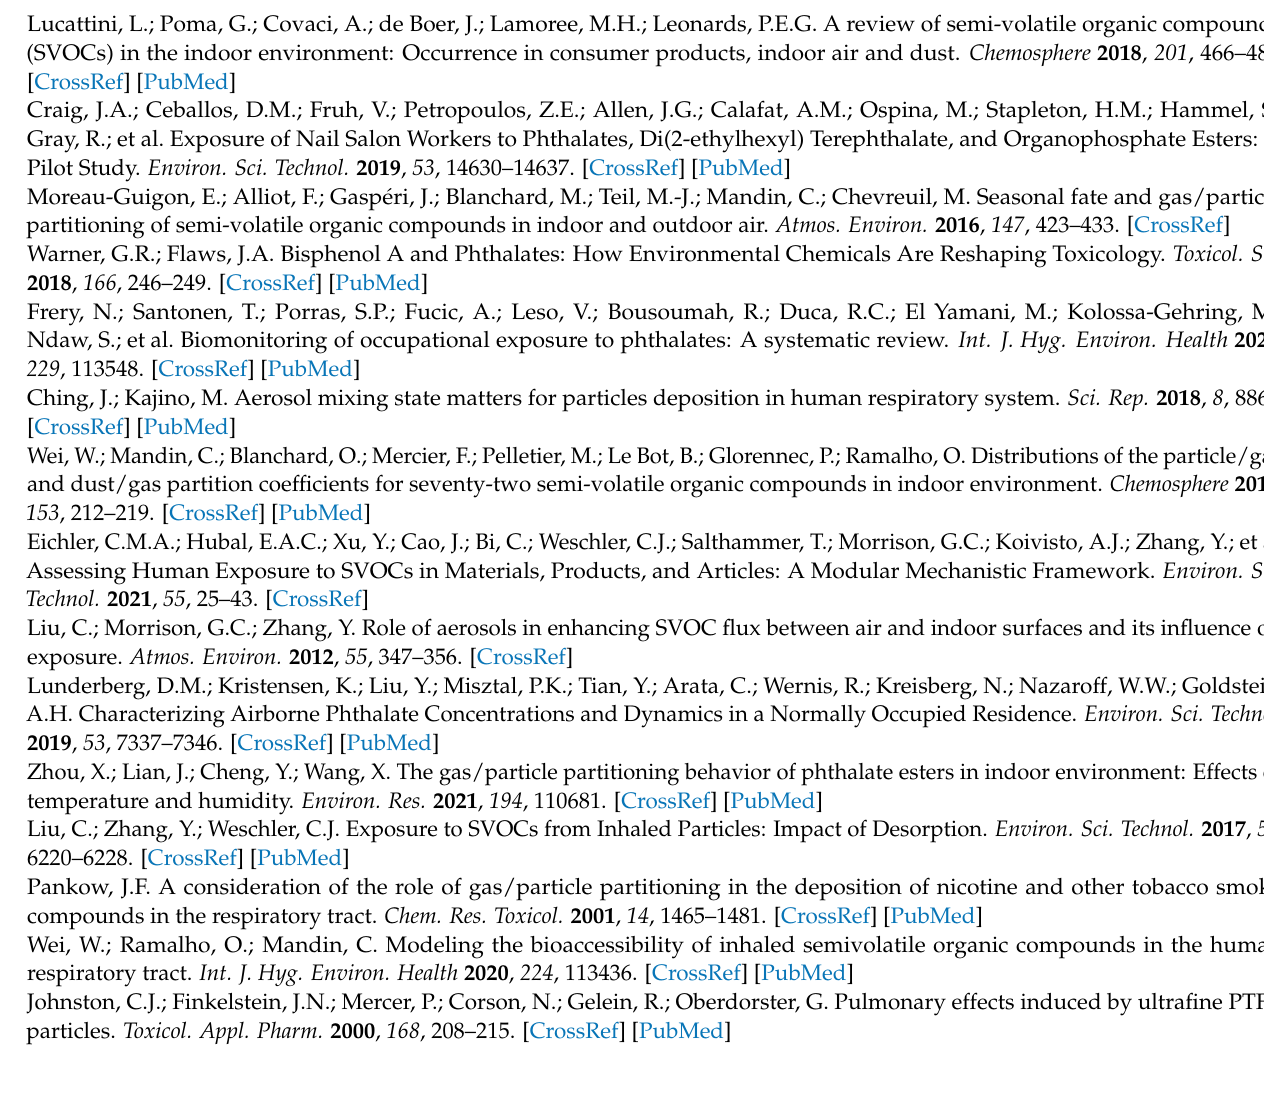
Figure A5. ( a ) Genotoxicity of negative ((i-)CA, NC) and positive controls (Pos ctrl) assessed by comet assay with the alkaline version (Pos ctrl 30 µ M H 2 O 2 ) and ( b ) the enzyme version with Fpg (Pos ctrl 1.5 mM KBrO 3 ) and the respective Buffer controls (without Fpg) after the respective time points ( n ≥ 3). iCA = independent clean air, CA = clean air, Data are shown as mean ± SD. Significances are shown in comparison to the negative controls (Statistical analysis via Tukey One-way ANOVA, *** p ≤ 0.001).